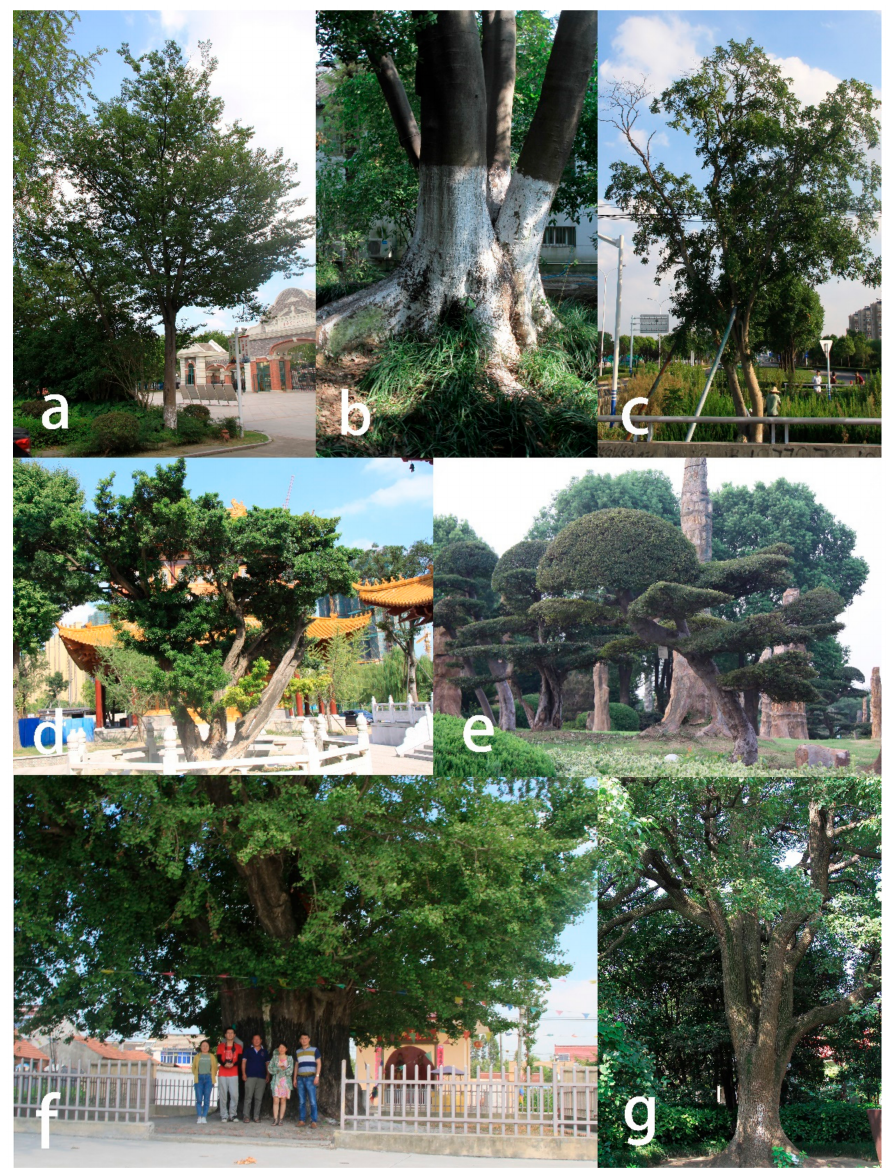
Figure 10. Photographs of main heritage trees and their tree habitats in Jiangsu Province, eastern China. ( a )